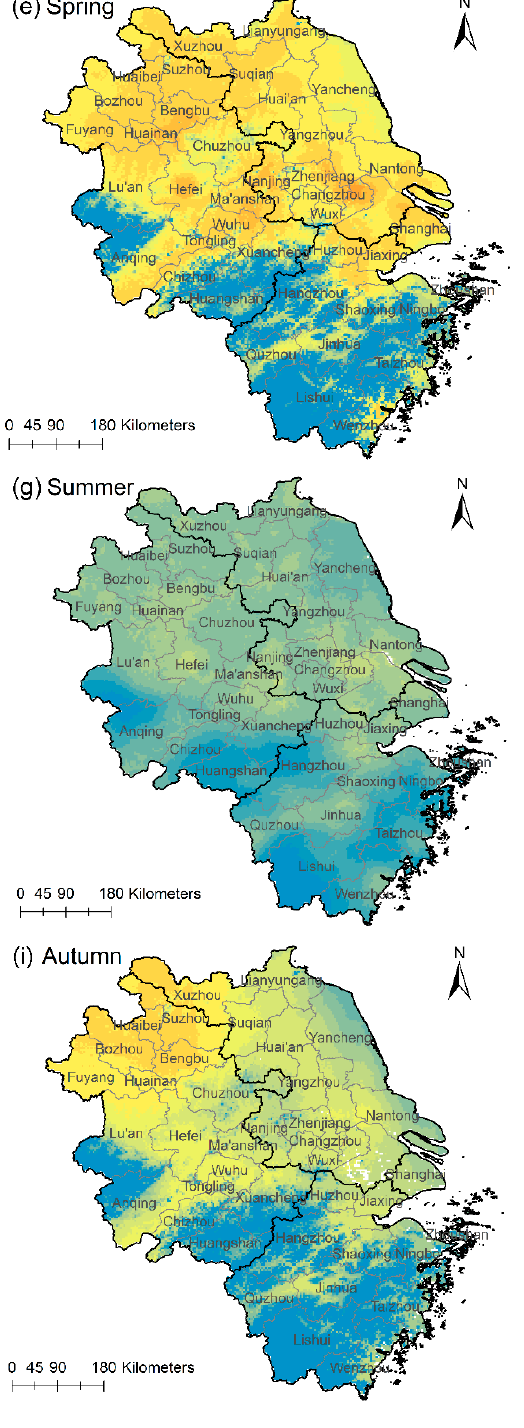
Figure 8. Annual and seasonal PM2.5 distribution maps ( a , c , e , g , i ) and eigenvector maps ( b , d , f , h , j ).